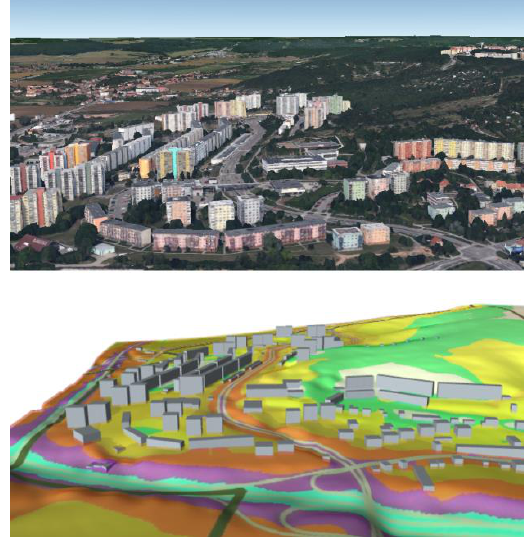
Fig. 3. Photorealistic visualization from Google Earth and abstract visualization of 3D noise map. Area of city